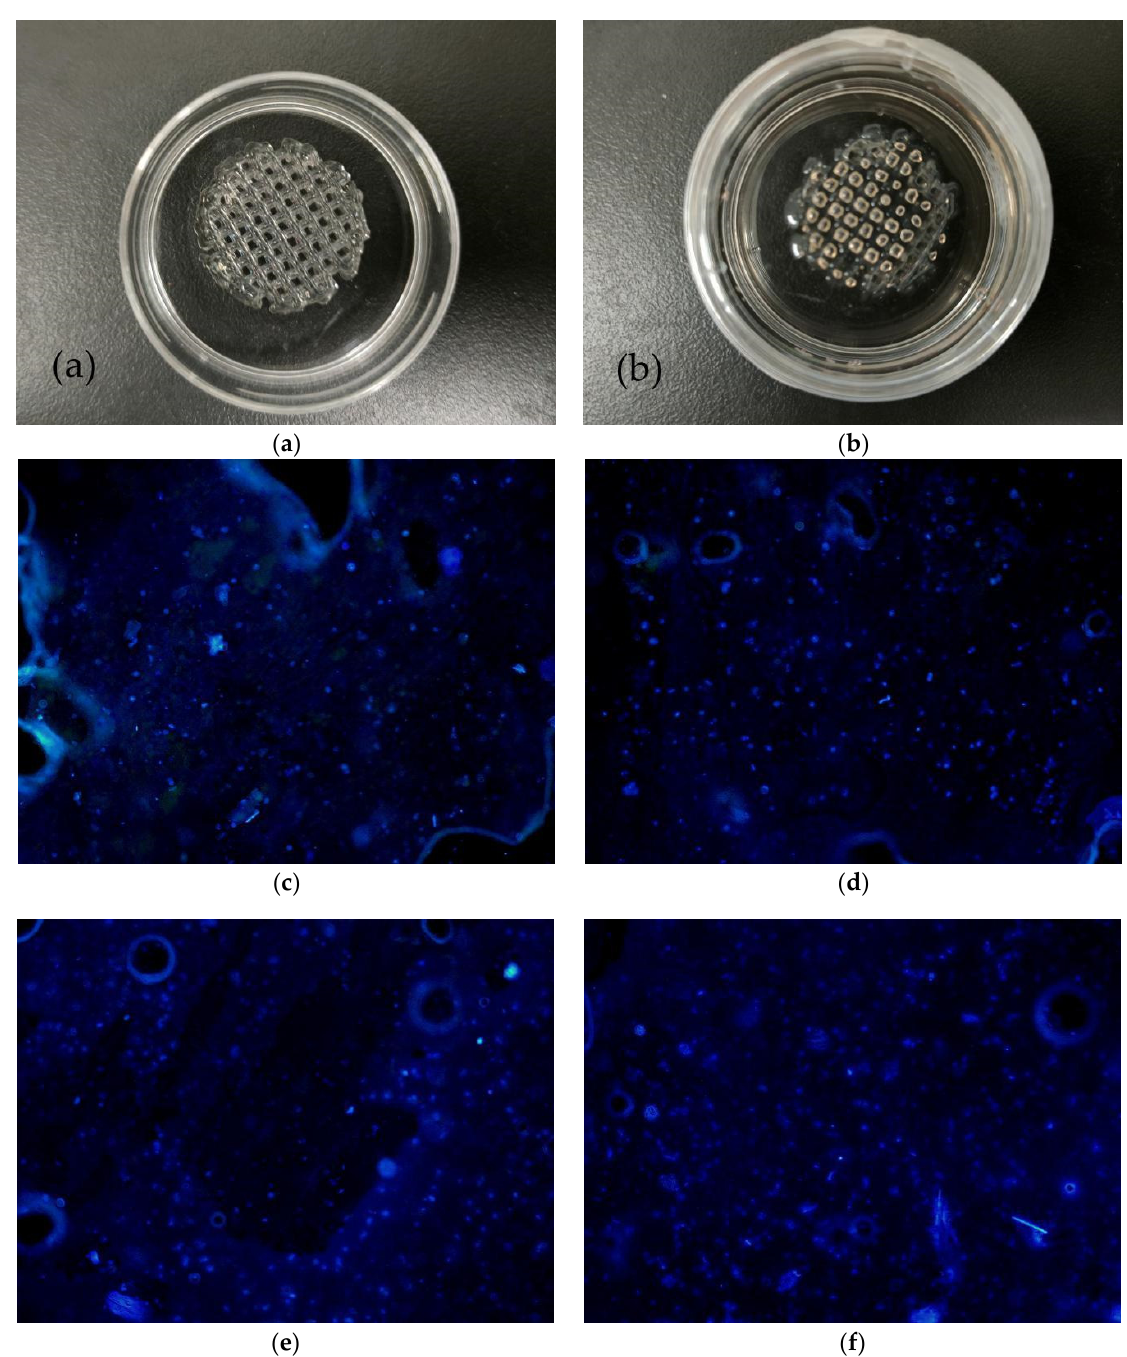
Figure 12. ( a ) The shaped structure with cells. ( b ) Cell-containing structure added to culture medium. ( c ) Cell proliferation on the first day of culture. ( d ) Cell proliferation on the second day of culture. ( e ) Cell proliferation on the fourth day of culture. ( f ) Cell proliferation on the sixth day of culture. Table 5. The cell proliferation rate in different periods.